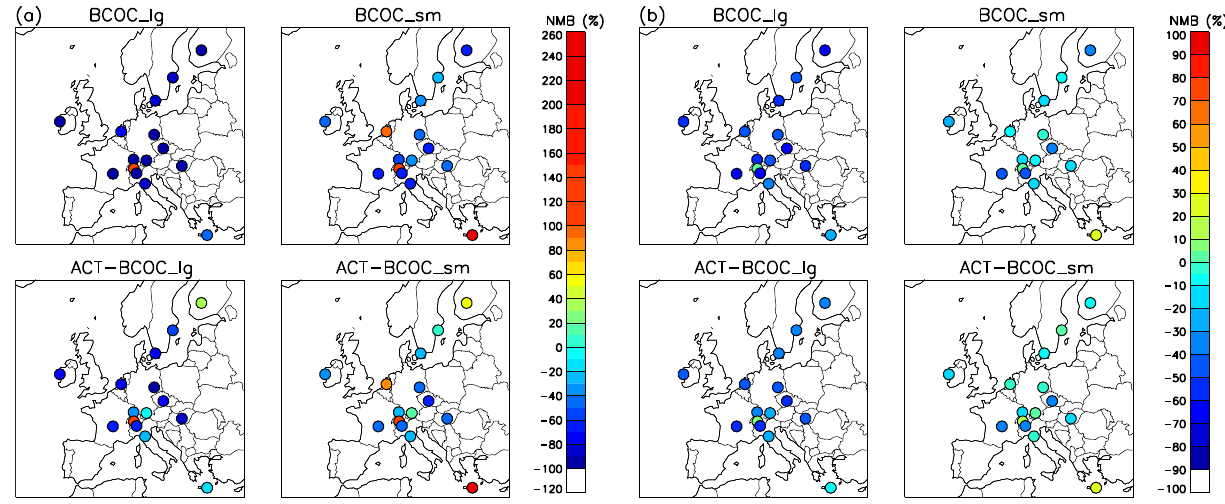
Fig. 5. Normalised mean bias (NMB) between hourly-mean modelled and observed particle number concentrations at each ground site. NMB is shown for model experiments 1–4, Table 2 for number concentrations in the size ranges; (a) D p =15–50nm and (b) D p >